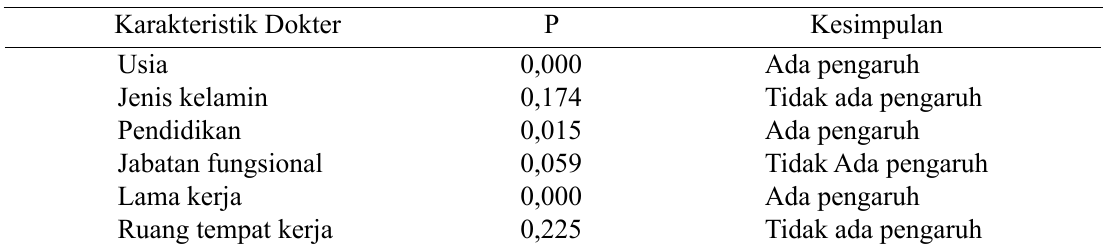
Tabel 2. Tabel pengaruh karakteristik dokter secara parsial terhadap sikap dokter tentang